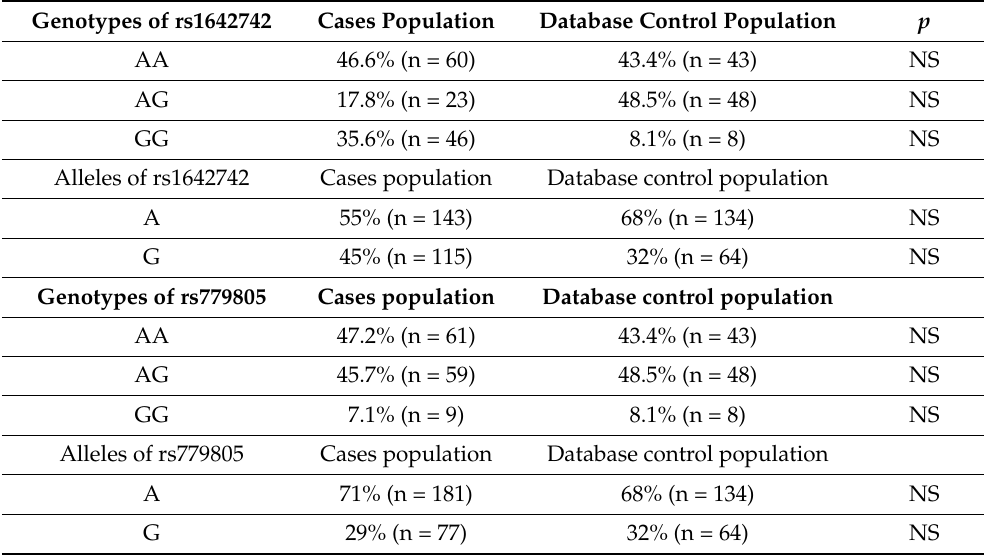
Table 3. Genotype and allele frequencies of VHL polymorphisms among the ccRCC cases and control population.